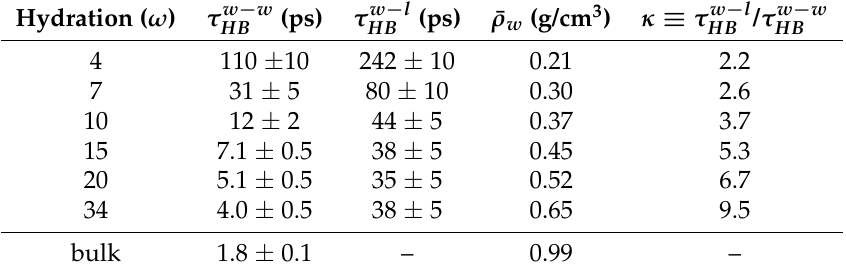
( t ) , τ w − α Table 3. Relaxation times of the correlation functions C w − α , with α = w , l , for stacked HB HB phospholipid membranes with hydration level ω . For each system, we provide the value of the average N w / ( A XY d ) , where N w is the number of water molecules in the system, water density, given by ¯ ρ w ≡ × A XY is the area of the membrane, and d is the width of the water–membrane interface. We also explicitly l with respect to the w w indicate the slowing-down factor κ of the w − −